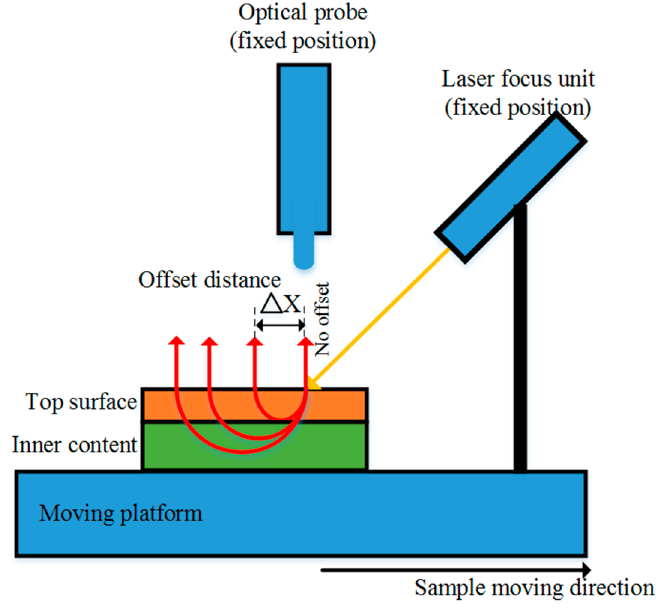
Figure 8. Spatially offset Raman spectroscopic technique for subsurface detection.